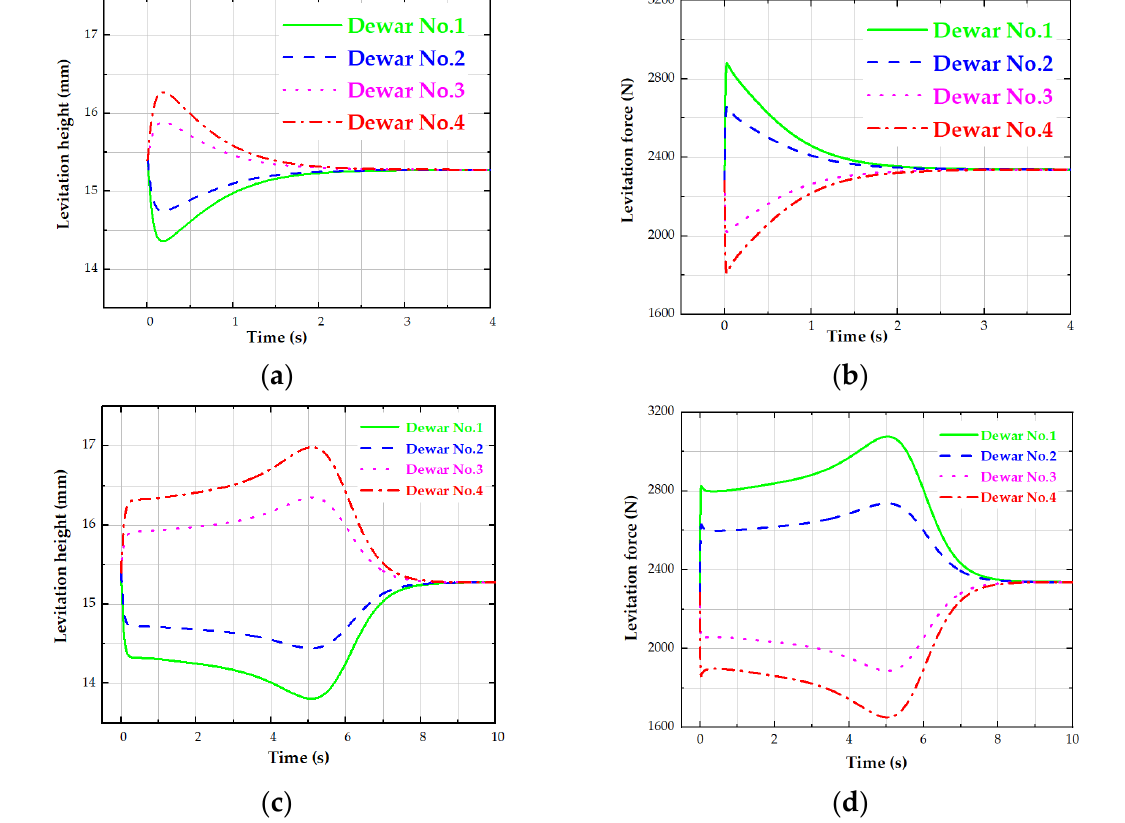
Figure 11. Effect of the detent force on the levitation performance of the vehicle: ( a ) change process of levitation heights of Dewar No. 1, No. 2, No. 3 and No. 4 at V 0 = 60 km/h under 10 mm air gap, ( b ) change process of levitation forces of Dewar No. 1, No. 2, No. 3 and No. 4 at V 0 = 60 km/h under 10 mm air gap, ( c ) change process of levitation heights of Dewar No. 1, No. 2, No. 3 and No. 4 at V 0 = 600 km/h under 10 mm air gap, ( d ) change process of levitation forces of Dewar No. 1, No. 2, No. 3 and No. 4 at V 0 = 600 km/h under 10 mm air gap.